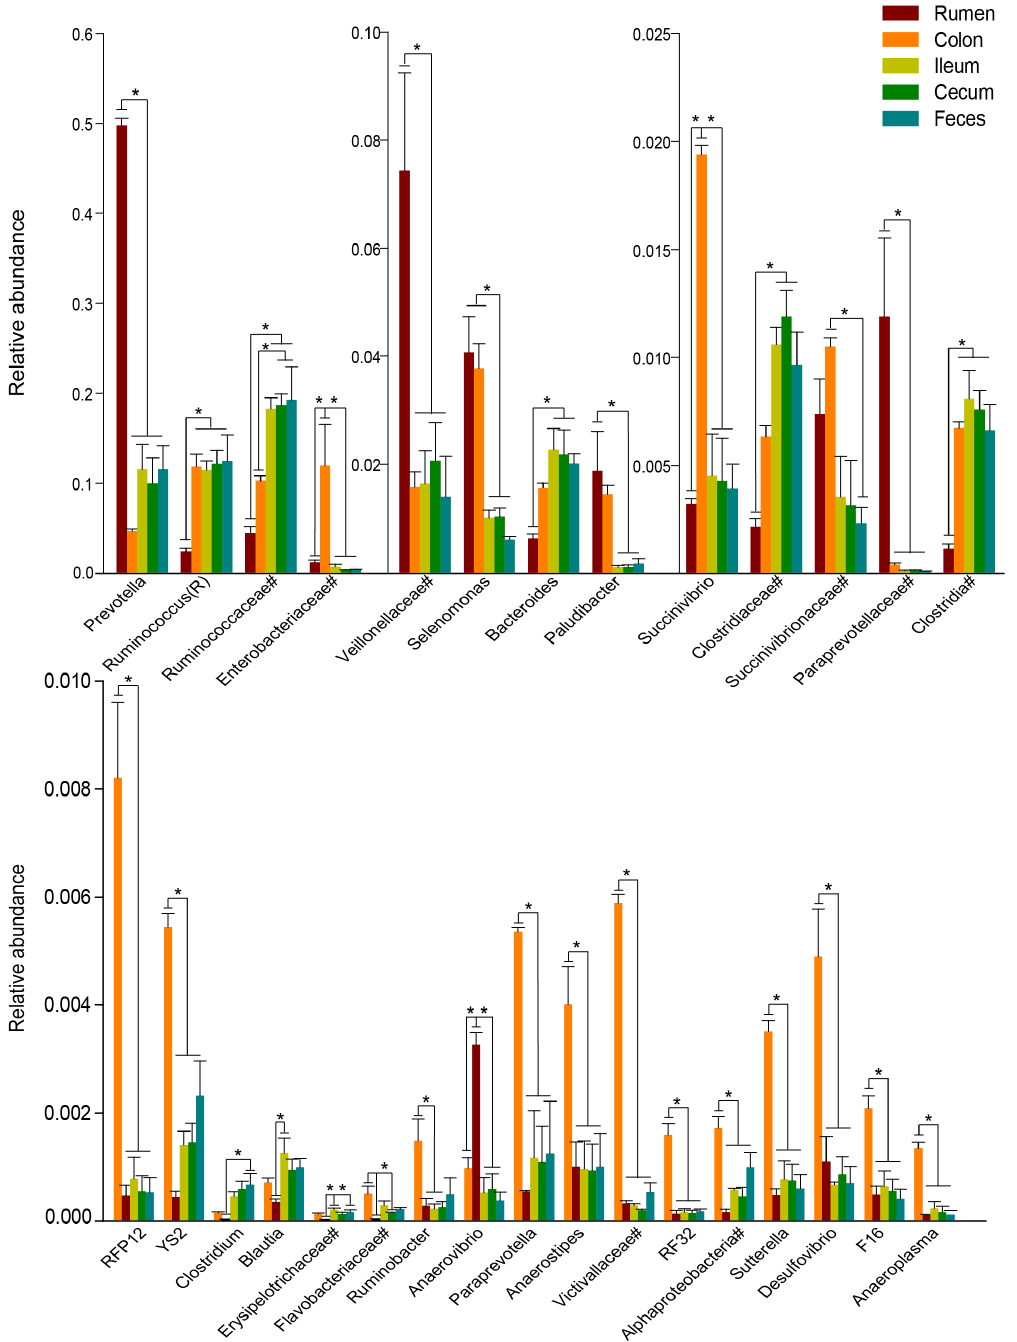
Figure 5. Significant difference at genus level of bacterial communities along the GITof three roe deer. The asterisk indicates P , 0.05, and # means the unclassified bacteria at the family, order, or class levels.